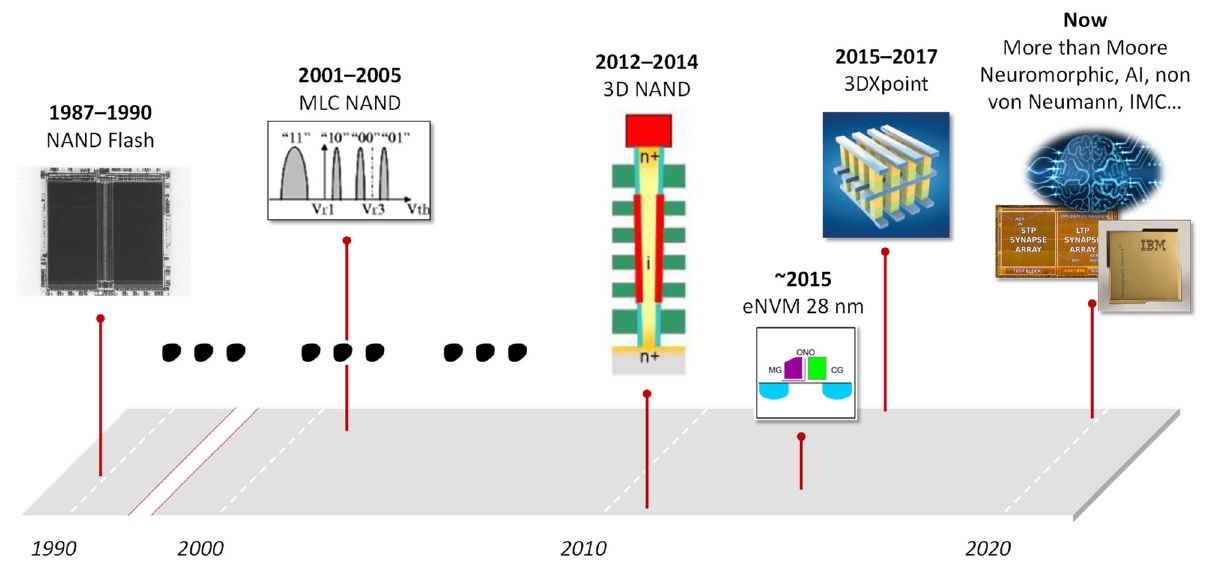
Figure 1. Main milestones in the history of nonvolatile memories.